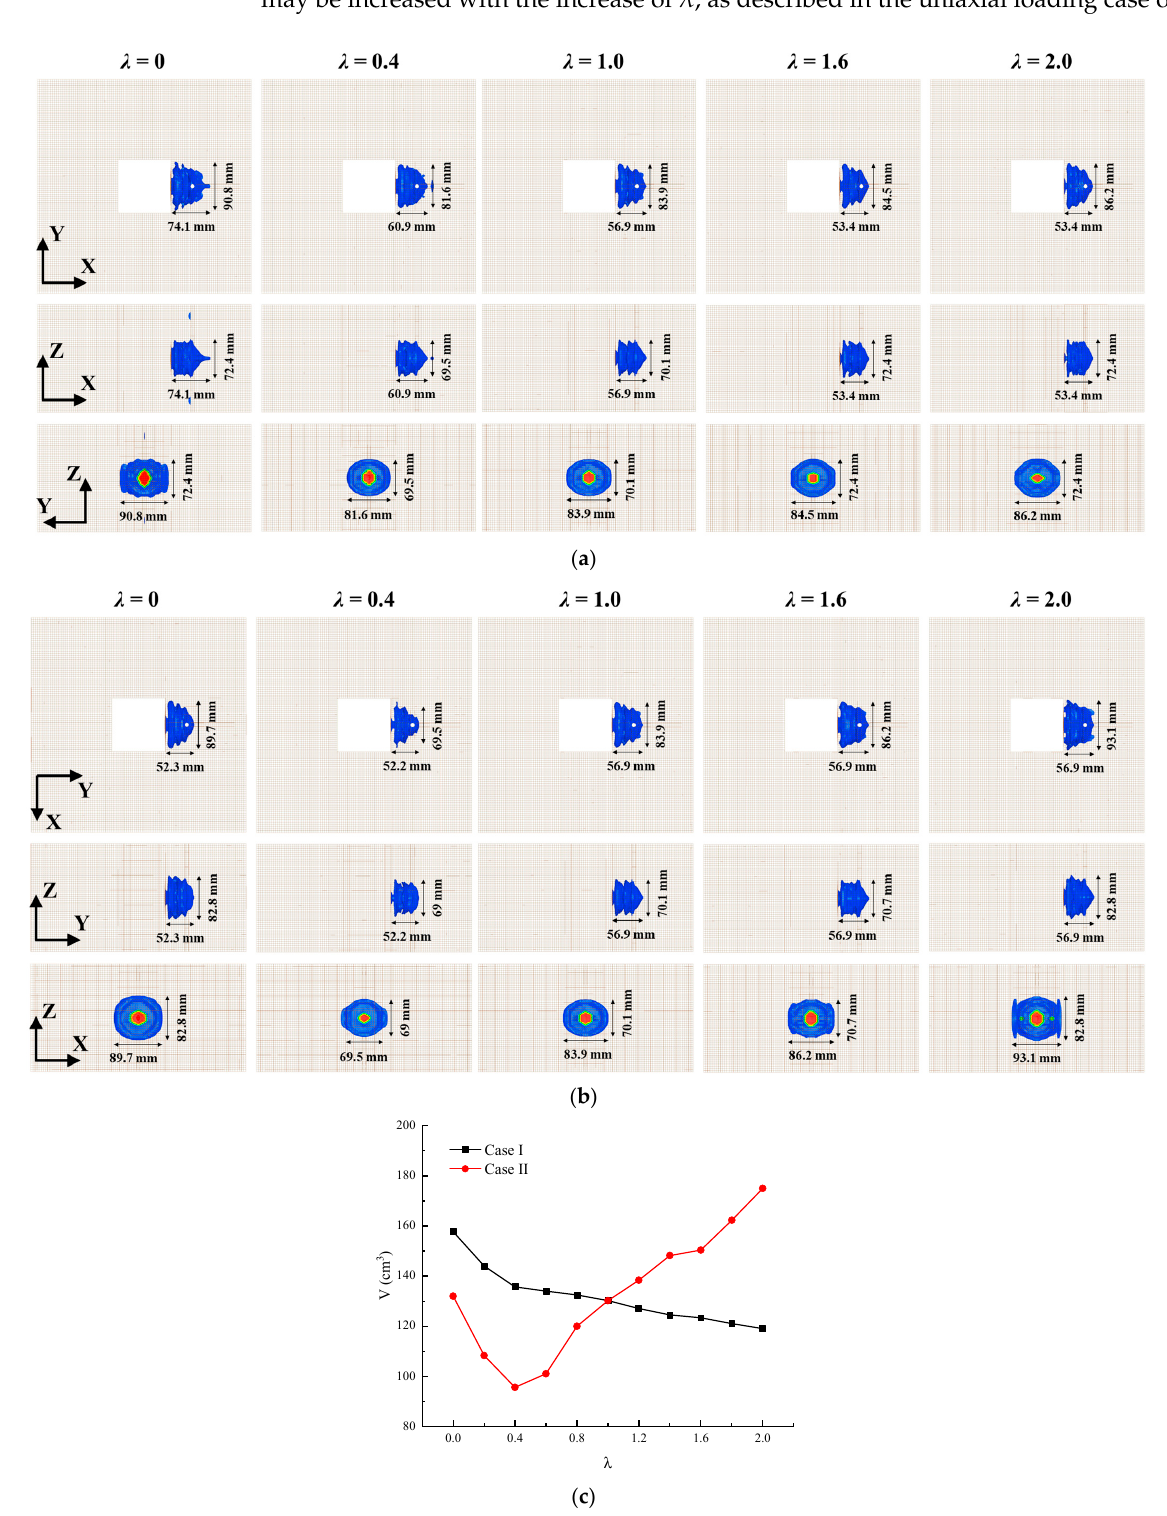
Figure 11. The shapes and the volumes of craters for W = 4 cm under biaxial loads with different λ (P1 = 5 MPa): ( a ) case I; ( b ) case II; ( c ) volume with λ